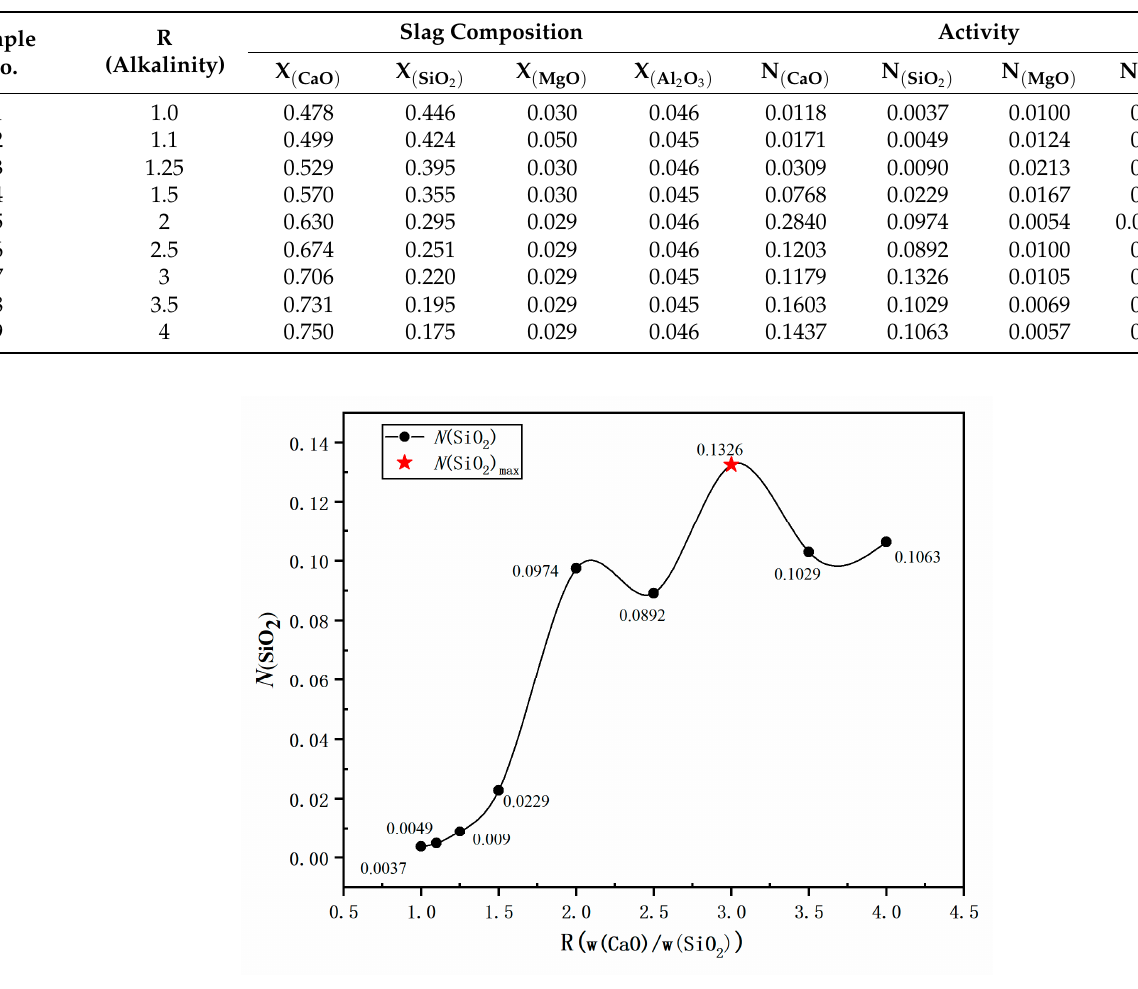
Figure 6. Model predicted values: effect of R(w(CaO)/w(SiO 2 )) on SiO 2 activity in slag.